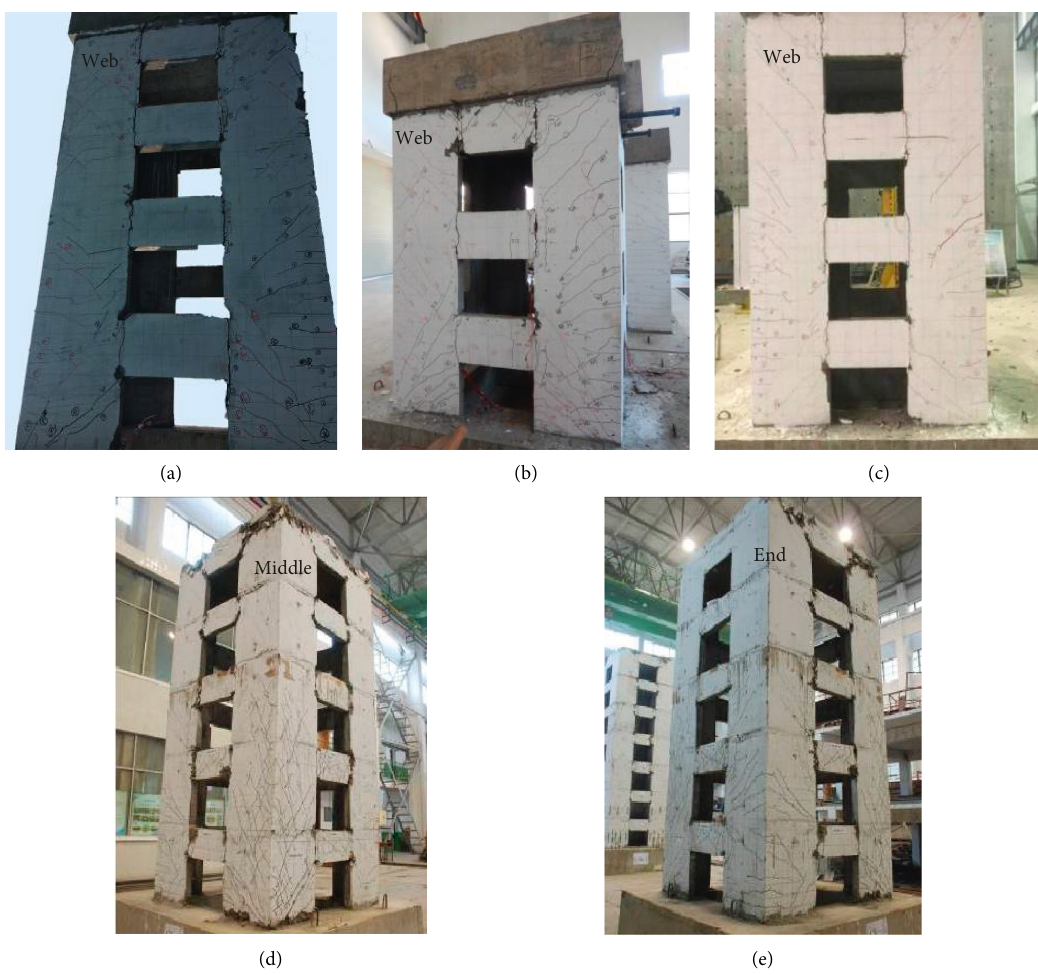
Figure 7: Failure patterns of available core walls. (a) CW4X-1 [13]. (b) CW3X-2 [13]. (c) CW4X-2 [13]. (d) CW-5 (middle) [30]. (e) CW-5 (end) [30].